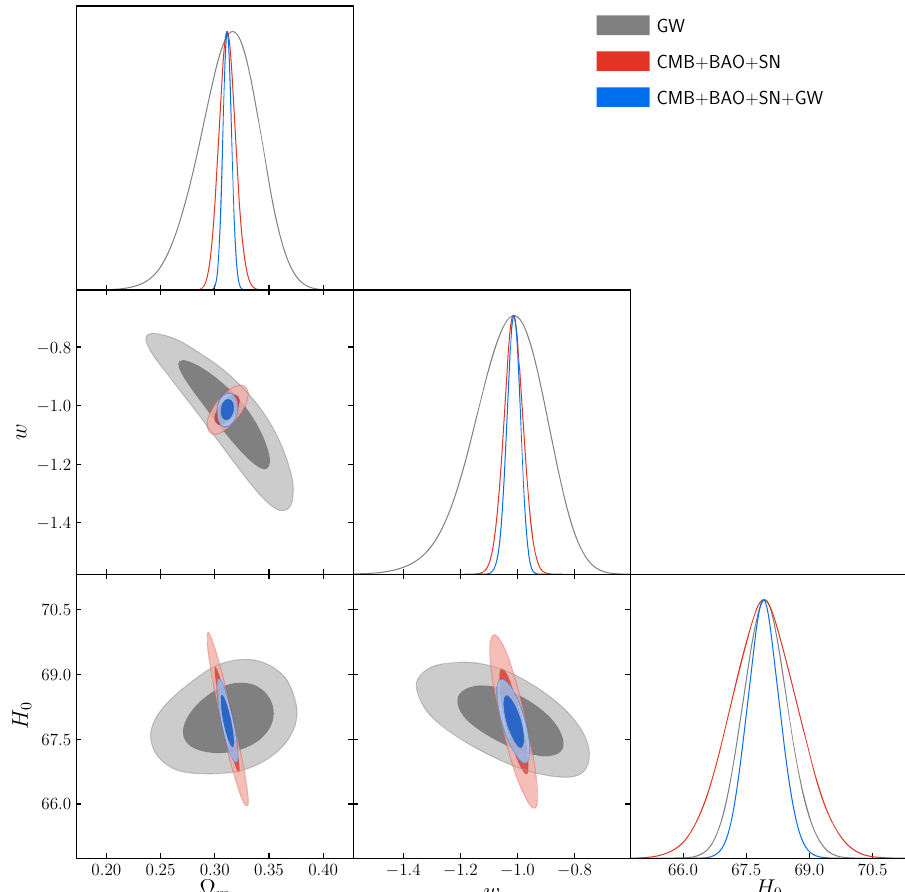
Fig. 2 Observational constraints (68.3% and 95.4% confidence level) on the w CDM model by using the GW, CMB + BAO + SN, and CMB + BAO